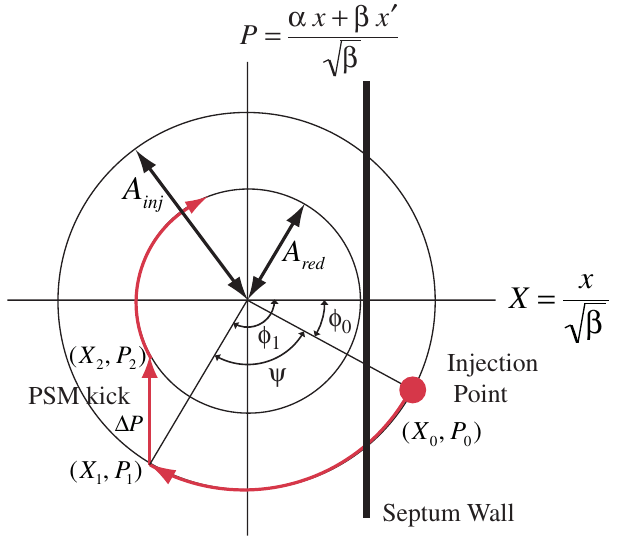
FIG. 2. (Color) A trajectory of an injected beam in PSM injec- tion (red) on a normalized phase space. ð X 0 ; P 0 Þ , ð X 1 ; P 1 Þ , and ; P Þ are the positions of the injected beam at the injection ð X 2 2 point, just before and after the kick at the PSM location. The radius of the outer circle, A inj , is the square root of the Courant- Snyder invariant for the injected beam before the PSM kick, and that of the inner circle, A red , is one after the PSM